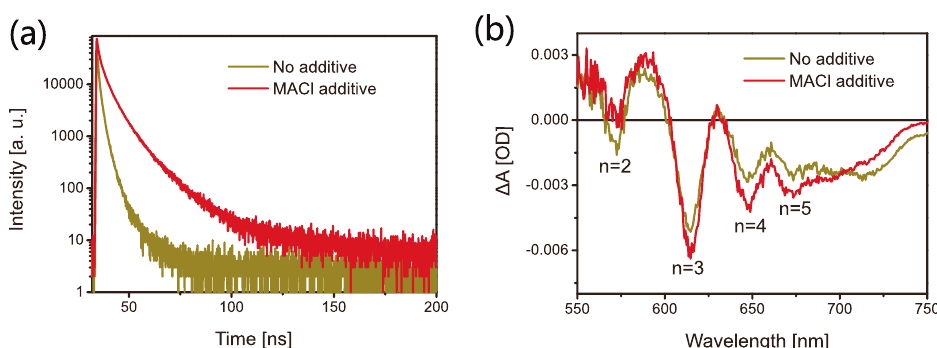
Fig. 4 Photophysics characterization of the drop-cast fi lms. a Time-resolved photoluminescence decay (excitation: 400 nm; emission: >700 nm) and b TA spectra at a delay time of 2 ps (excitation: 510 nm) for iso-BA-2D perovskite fi lms on glass prepared by N 2 blow-drying with and without MACl additive. For TRPL measurements, sample excitation and emission detection was from the glass (back) face. For TA, laser excitation was incident on the glass